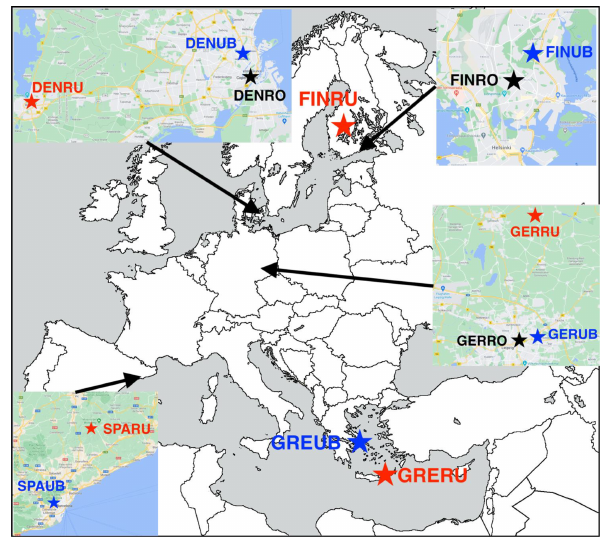
Figure 1. Map of the areas of study (map by © Google